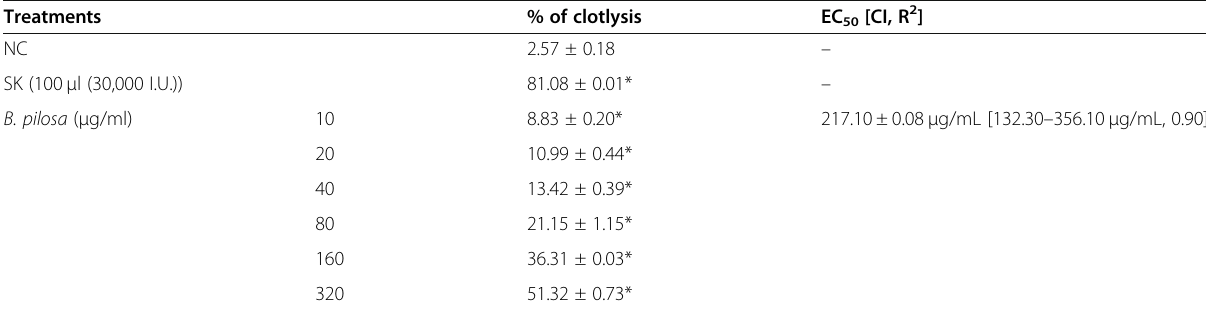
Table 3 Clot lysis capacity of B. pilosa ethanol extract and the controls